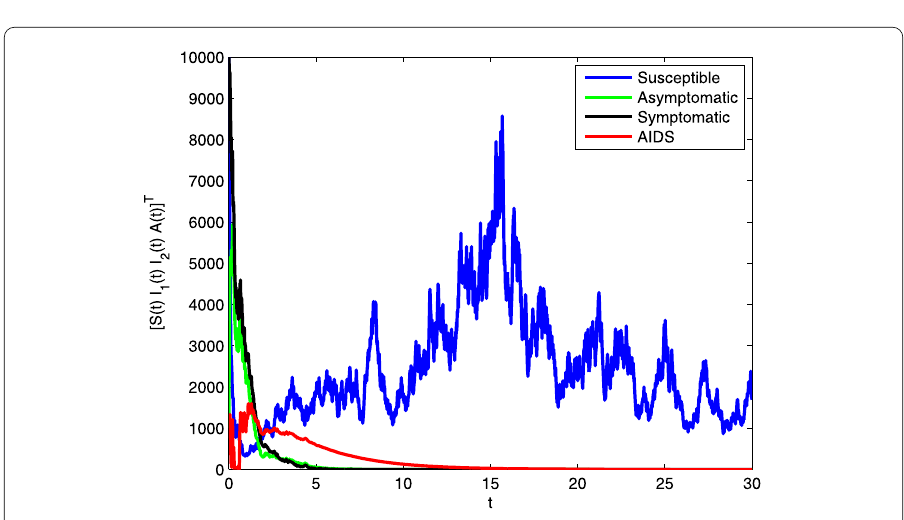
Figure 6 Simulations of system (37) with pulse vaccination parameter θ = 0.1 and ν =